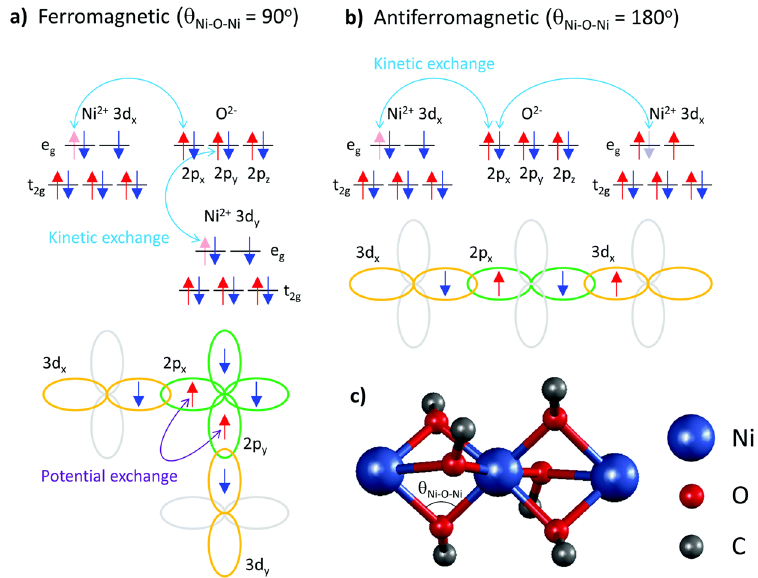
Figure 1. Super-exchange coupling between nearest-neighbor 3d orbitals of Ni via the ligands of O 2 − (2p orbitals). ( a ) In the case of a 90° angle between Ni-O-Ni, super-exchange results in a ferromagnetic coupling between the orthogonal oxygen 2p orbitals; ( b ) for an angle of 180° between Ni-O-Ni, an antiferromagnetic coupling occurs due to the nickel and oxygen orbitals overlapping; and ( c ) geometry of nickel(II) acetylacetonate (Ni(acac) 2 ) molecular magnets. From ref. [39], originally published under a CC-BY license.